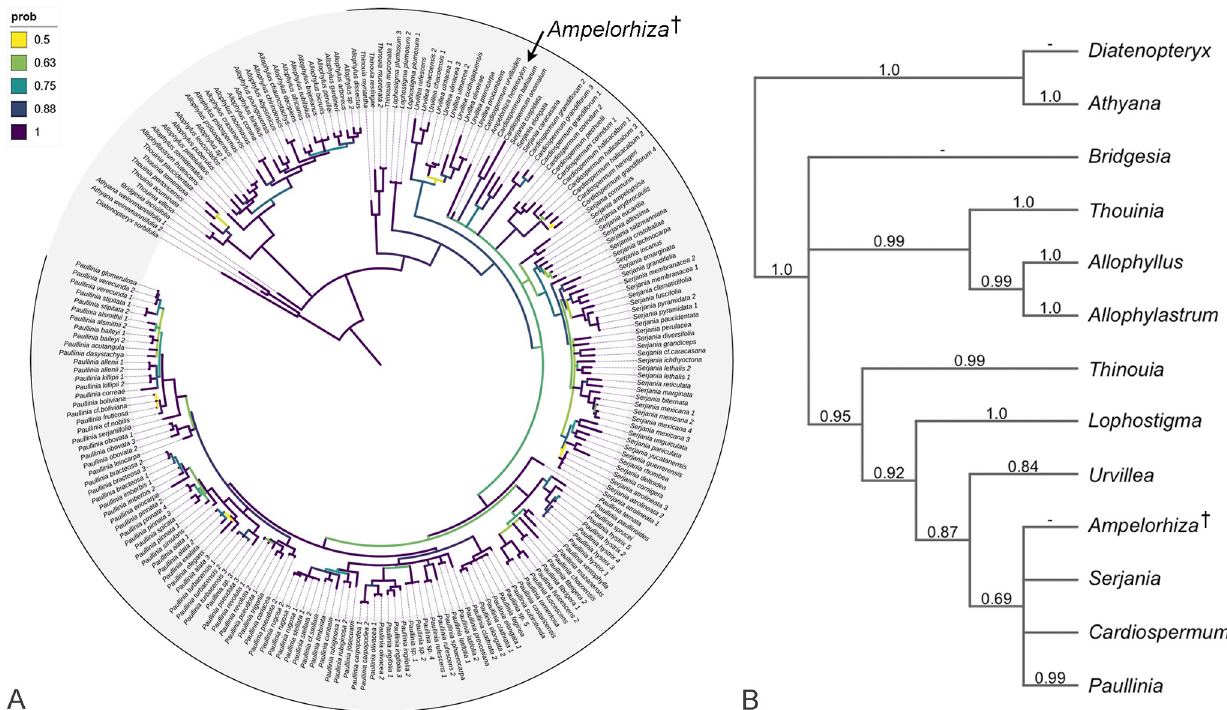
Fig 7. Phylogeny of supertribe Paulliniodae. (A) Majority rule consensus tree with all compatible groups (“allcompat”) of supertribe Paulliniodae sensu Acevedo et al. [21], generated in MrBayes 3.2.7 from an anatomical and molecular combined dataset of 216 tips. Branch colors indicate posterior probabilities. The outermost black line indicates the tribe Paullinieae. Note the position of the fossil taxon Ampelorhiza within Paullinieae indicated by the arrow and the dagger. (B) Summary tree showing the same topology, but pruned to show genera only, assuming all genera are monophyletic. Numbers above branches are posterior probabilities, dashes indicate genera represented by a single species in the “allcompat” consensus tree.